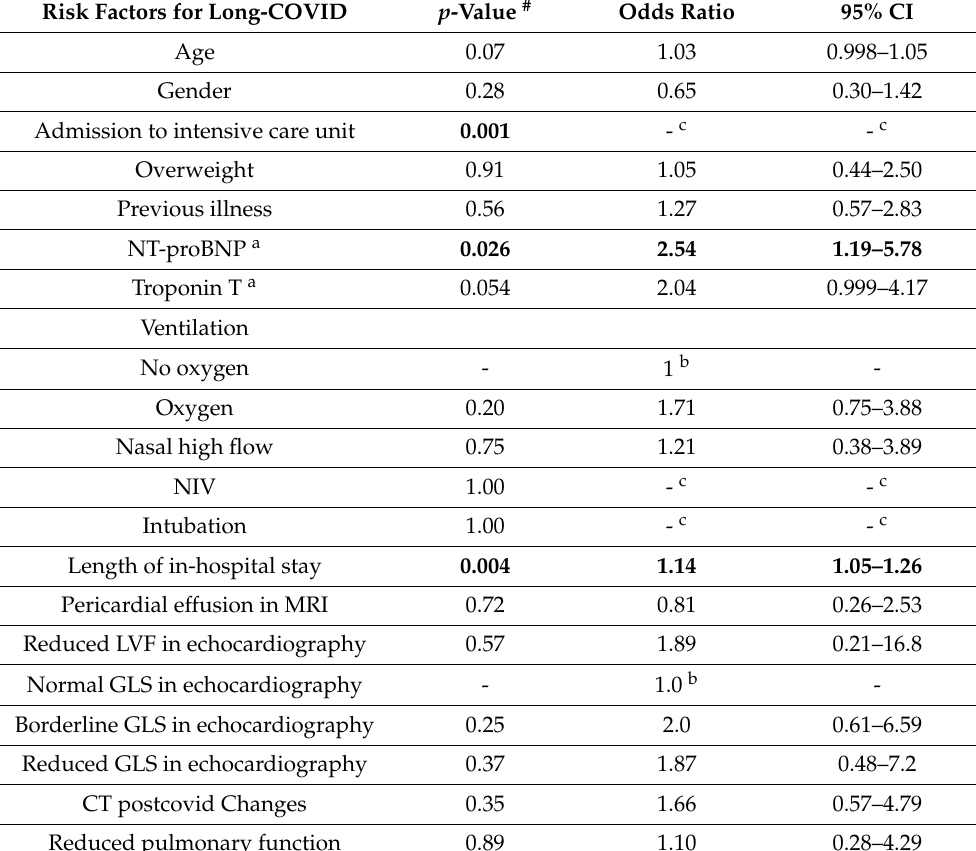
Table 3. Risk factors for developing Long-COVID.